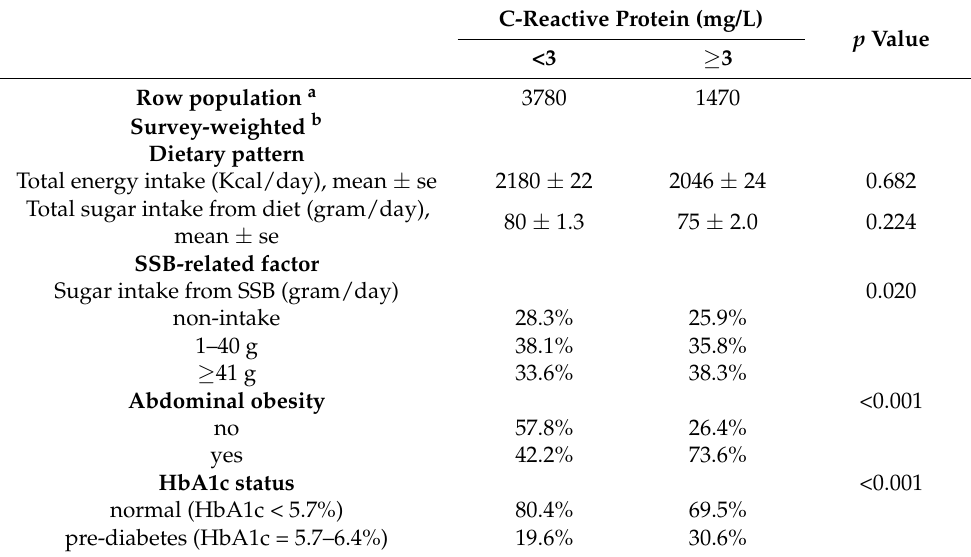
Table 2. Characteristics of dietary pattern, sugar intake, adiposity index, and hemoglobin A1c levels between C-reactive protein <3 and ≥ 3